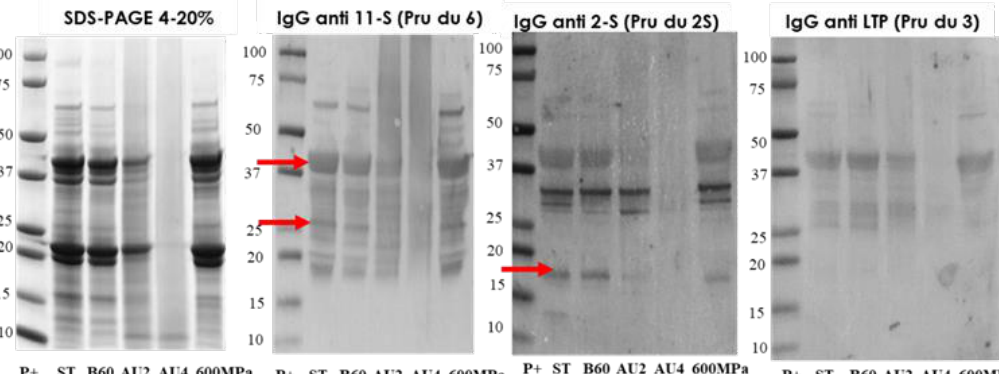
Figure 5. SDS-PAGE and IgG anti-11S, anti-2S, and anti-LTP immunoblots analysis of control (ST), boiled 60 min (B60) and autoclaved at 121°C at 30 min (AU2) and 138 °C 30 min (AU4) and HHP treated (600 MPa) almond samples. Molecular weight marker was Precision Plus (P+).